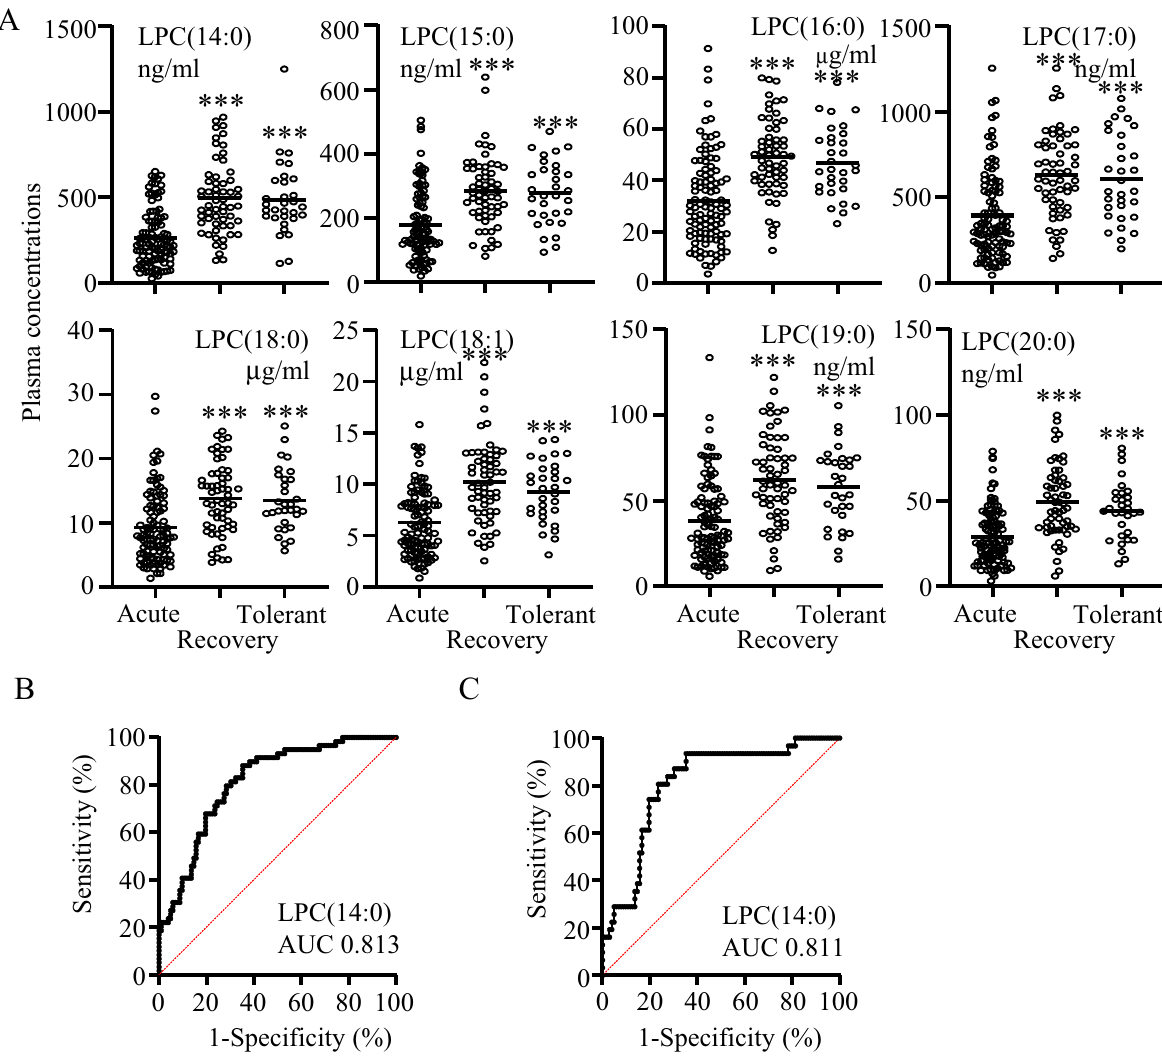
Figure 2. Validation of LPCs as DILD biomarkers. ( A ) Individual plot of plasma LPC concentrations in acute and recovery phase DILD and DILD-tolerant patients. *** p < 0.001 vs. acute phase. ( B ) ROC curve of LPC(14:0) concentrations between acute and recovery phase DILD patients. ( C ) ROC curve of LPC(14:0) concentrations between acute phase DILD patients and DILD-tolerant